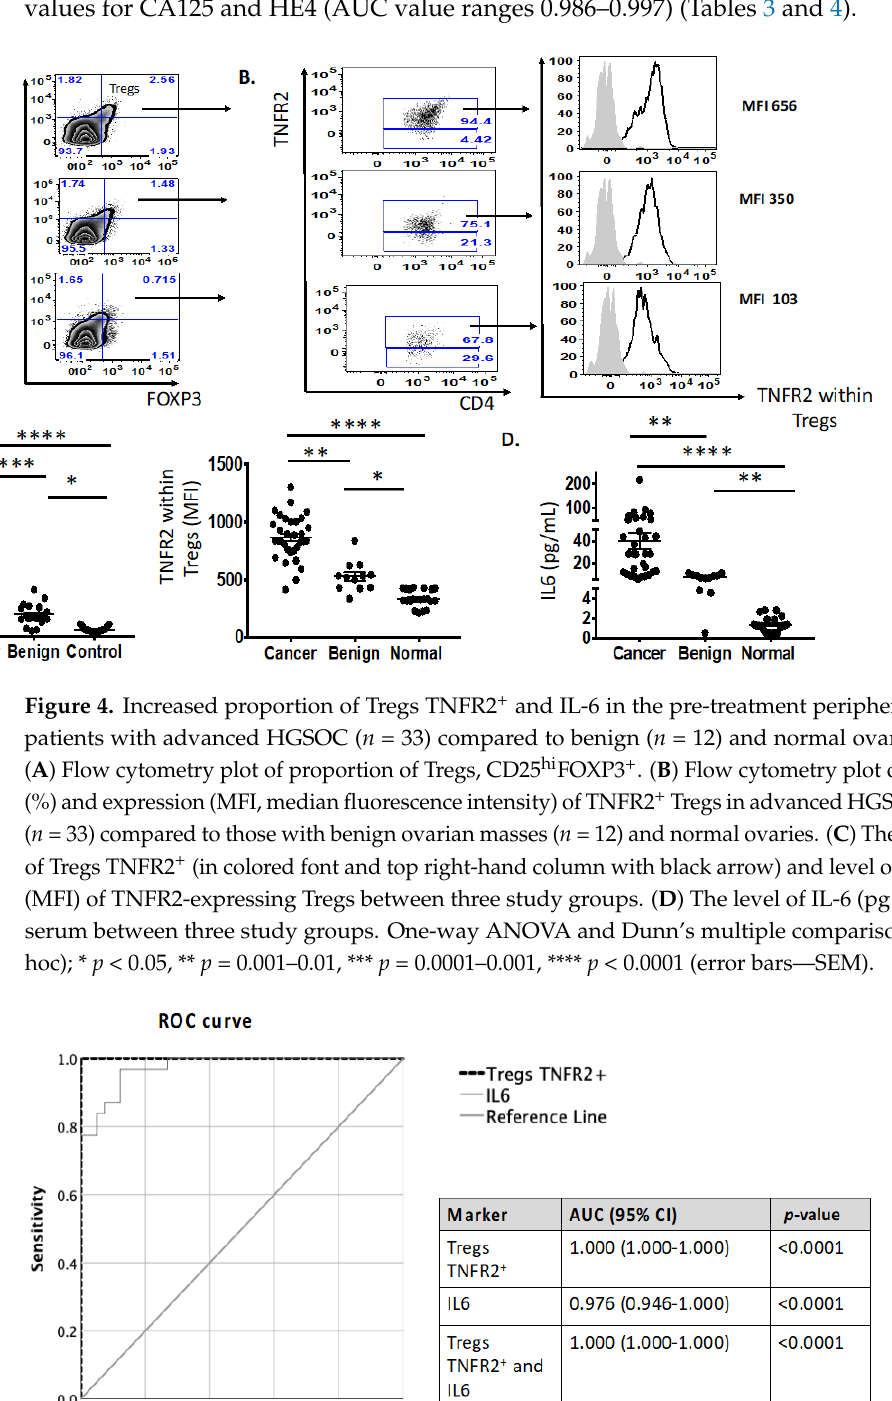
Table 4. Comparison of ROC-AUC values of pre-treatment soluble factor concentration for pa- tients with malignant and non-malignant ovarian masses.